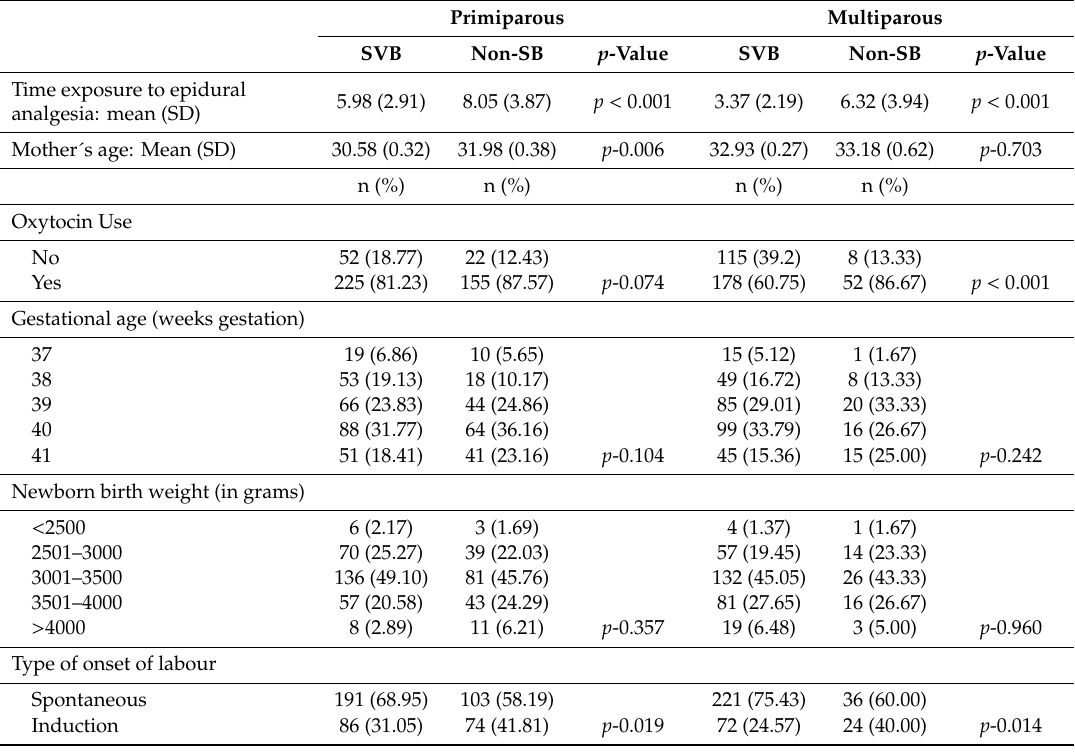
Table 3. The risk of non-spontaneous birth, maternal, fetal and birth characteristics by parity. Primiparous Multiparous SVB Non-SB p -Value SVB Non-SB p -Value Time exposure to epidural analgesia: mean (SD)